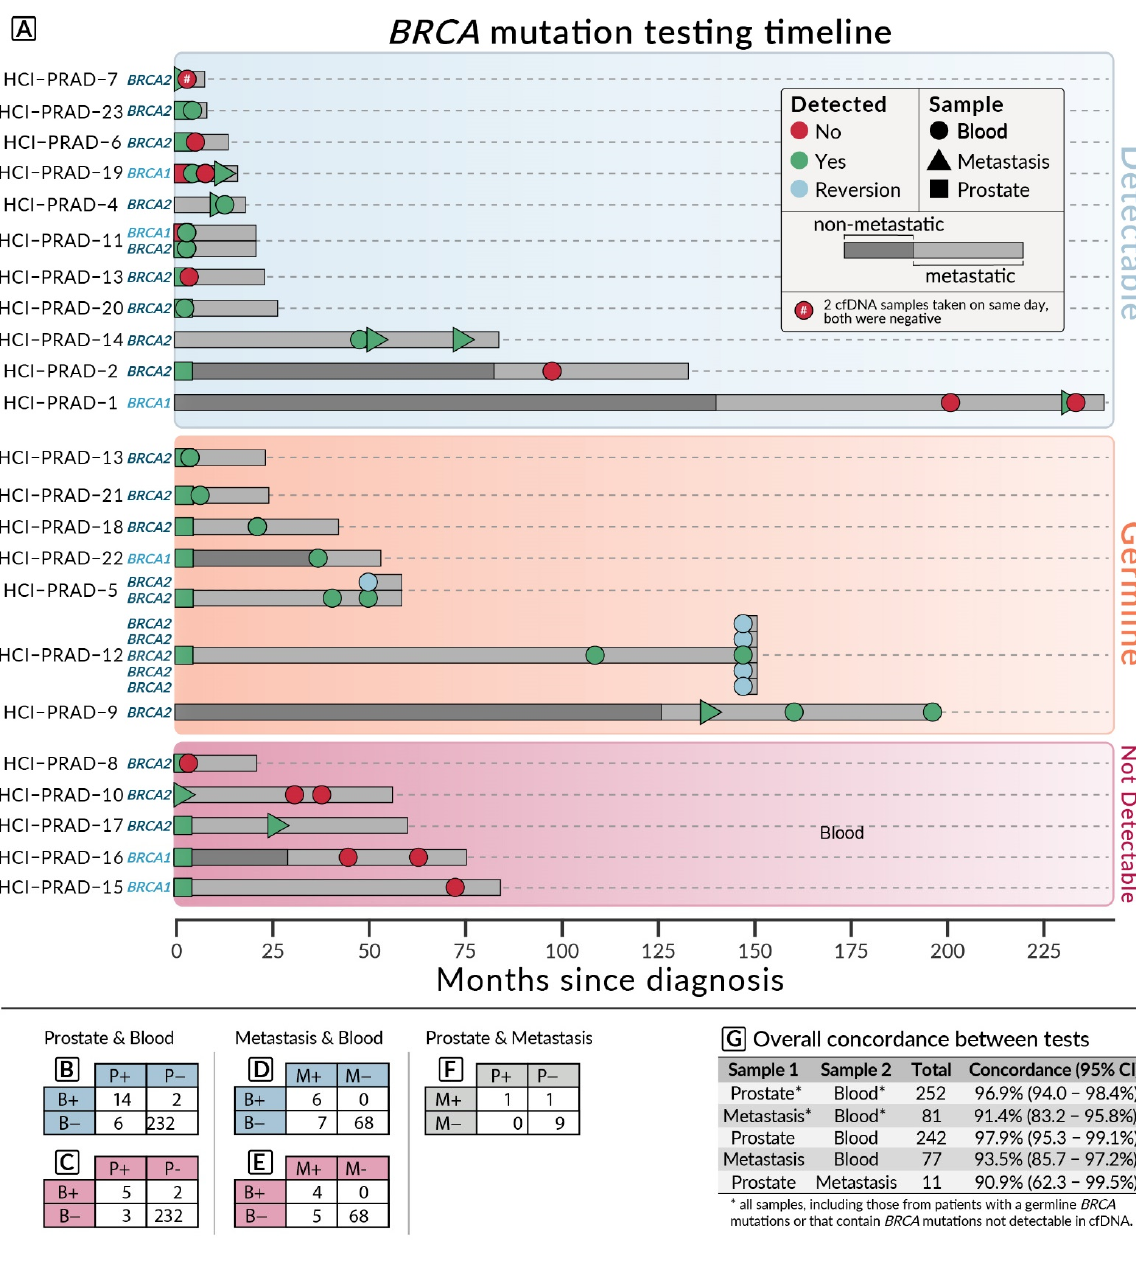
Figure 2. ( A ) Timeline of detection for the 23 patients with BRCA mutations. Each grey bar represents one mutation with total length of the bar indicating the time from first diagnosis to last follow up or death, except for the reversion mutations. Note that many of the patients were de novo meta- static. ( B – G ) Concordance tables for prostate (P), blood (B), and metastatic (M) samples showing the presence (+) or absence ( − ) of a BRCA mutation. ( B ) Prostate and blood, all samples. ( C ) Prostate and blood, without undetectable mutations. ( D ) Metastasis and blood, all samples. ( E ) Metastasis and blood, without undetectable mutations. ( B ) Prostate and metastasis, all samples.